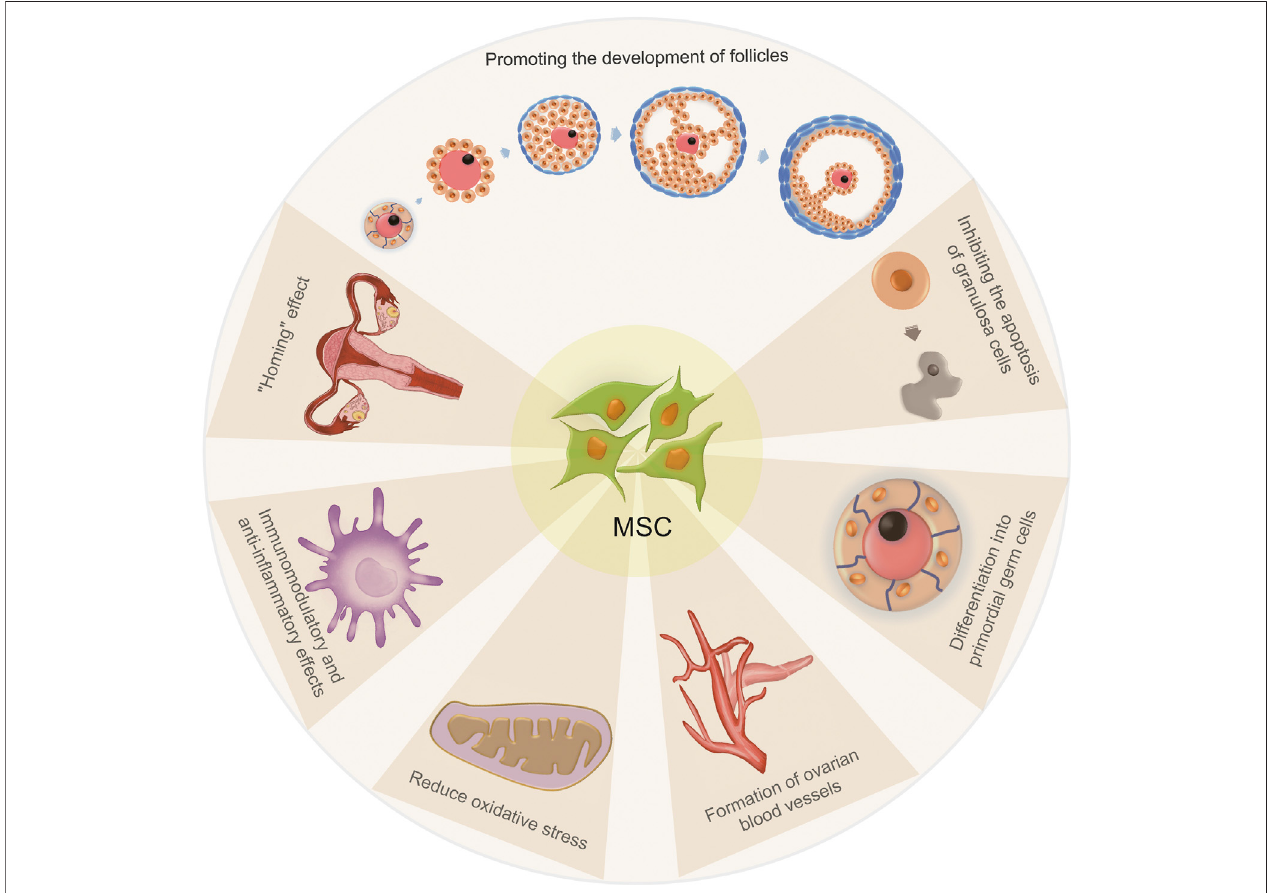
FIGURE 2 | The mechanisms of treating POF with